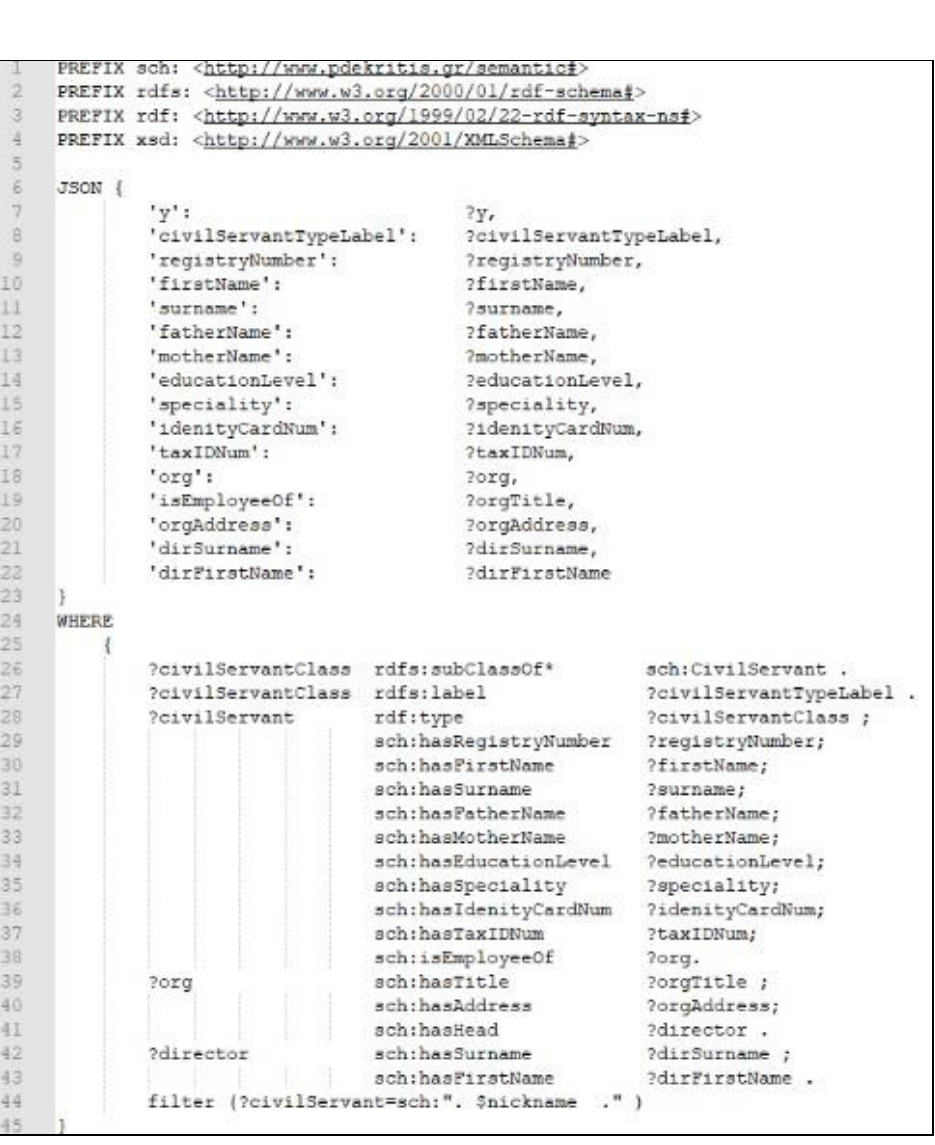
Figure 9. SPARQL query for retrieving Employee’s information.